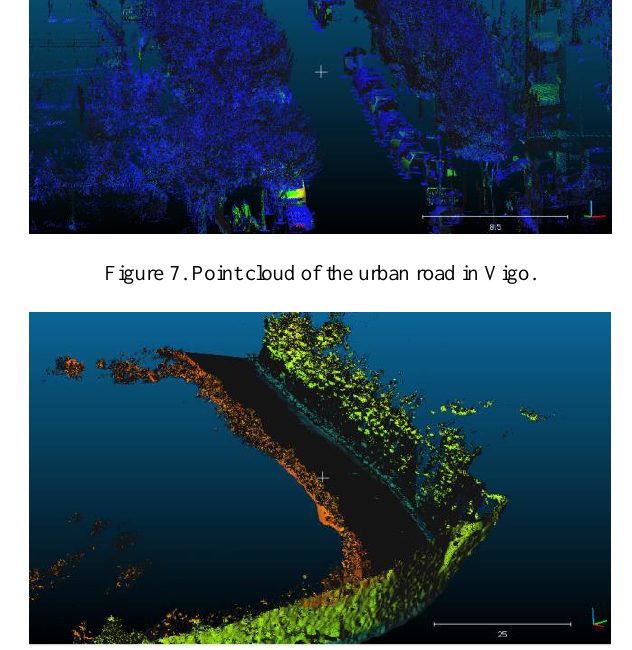
Figure 6. Mobile LiDAR Optech Lynx.